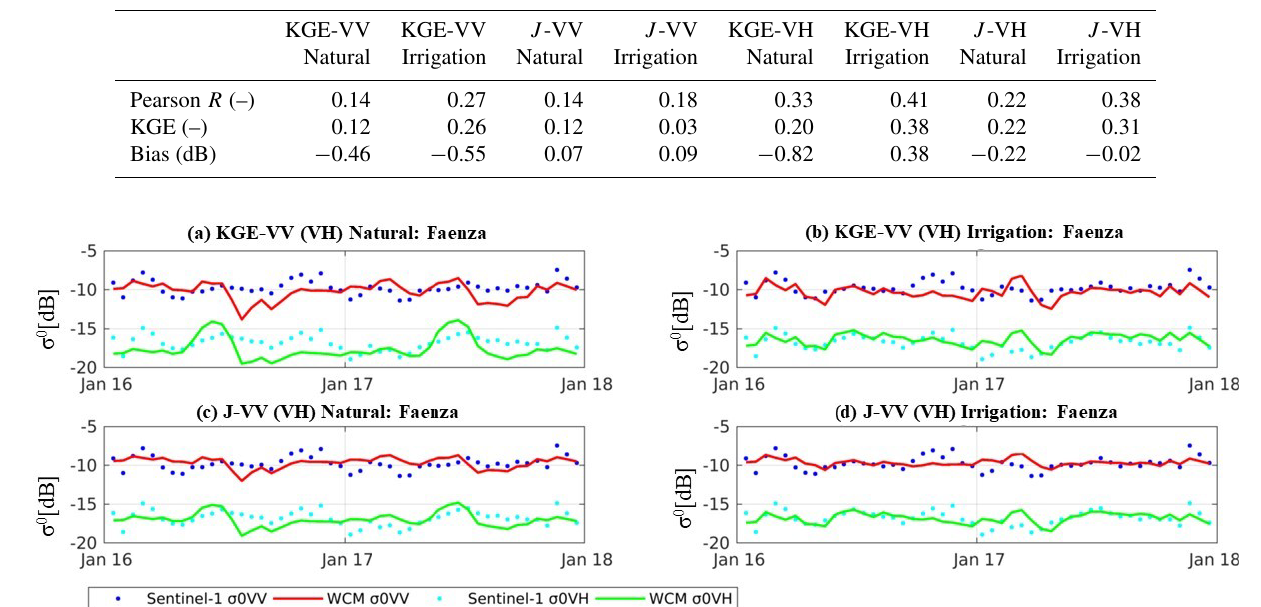
Table 2. Results of the site WCM evaluation considering the test site Faenza San Silvestro for each WCM experiment.